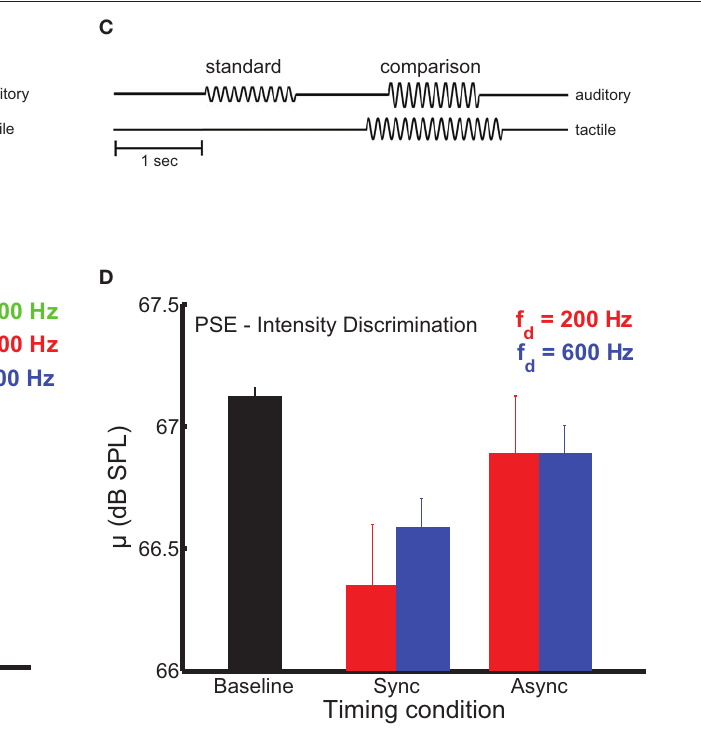
Figure 3 | Dependence of pitch and loudness bias interactions on stimulus timing. (A,B) Experimental design. The onset of distractors was 250 ms before and their offset 250 ms after the onset and offset of the auditory stimuli, respectively. (C) Mean bias estimates (PSE) on the frequency discrimination task (200-Hz standard) as a function of stimulus timing. The strength of the bias effect depended on distractor frequency (the green, red, and blue bars indicate the